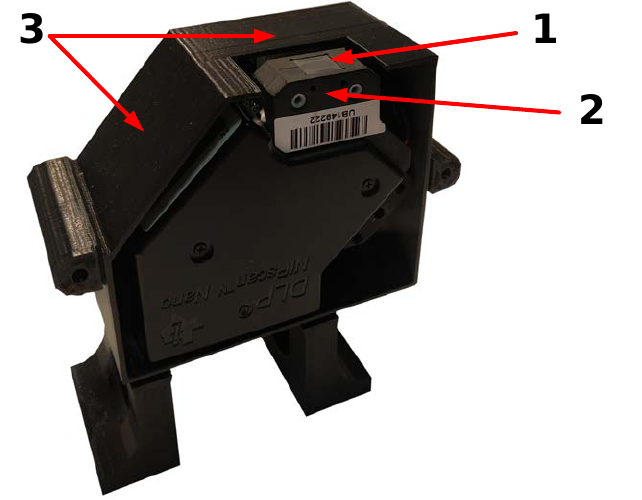
Figure 2. Design of the DLP NIRscan Nano EVM spectrometer with housing: 1, spectrometer window (place for a sample); 2, illumination-reflection module; 3, own design housing.